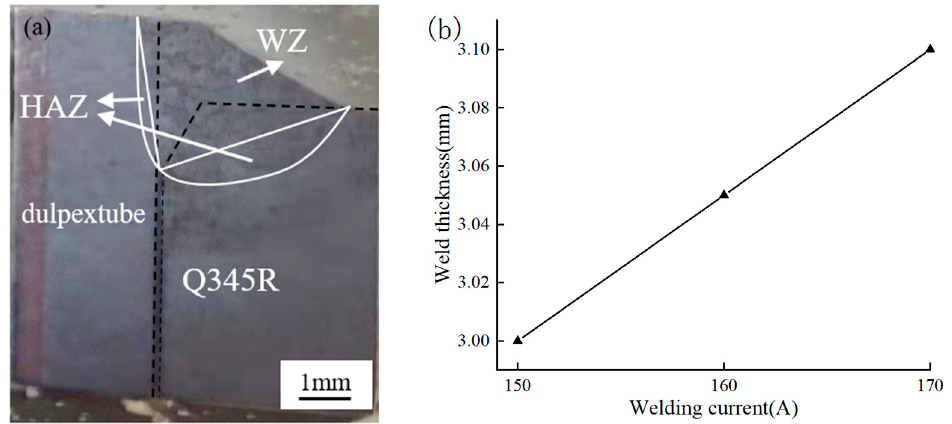
Figure 6. Welding section and welded width ( a ) weld joint section ( b ) weld width changed with welding current.